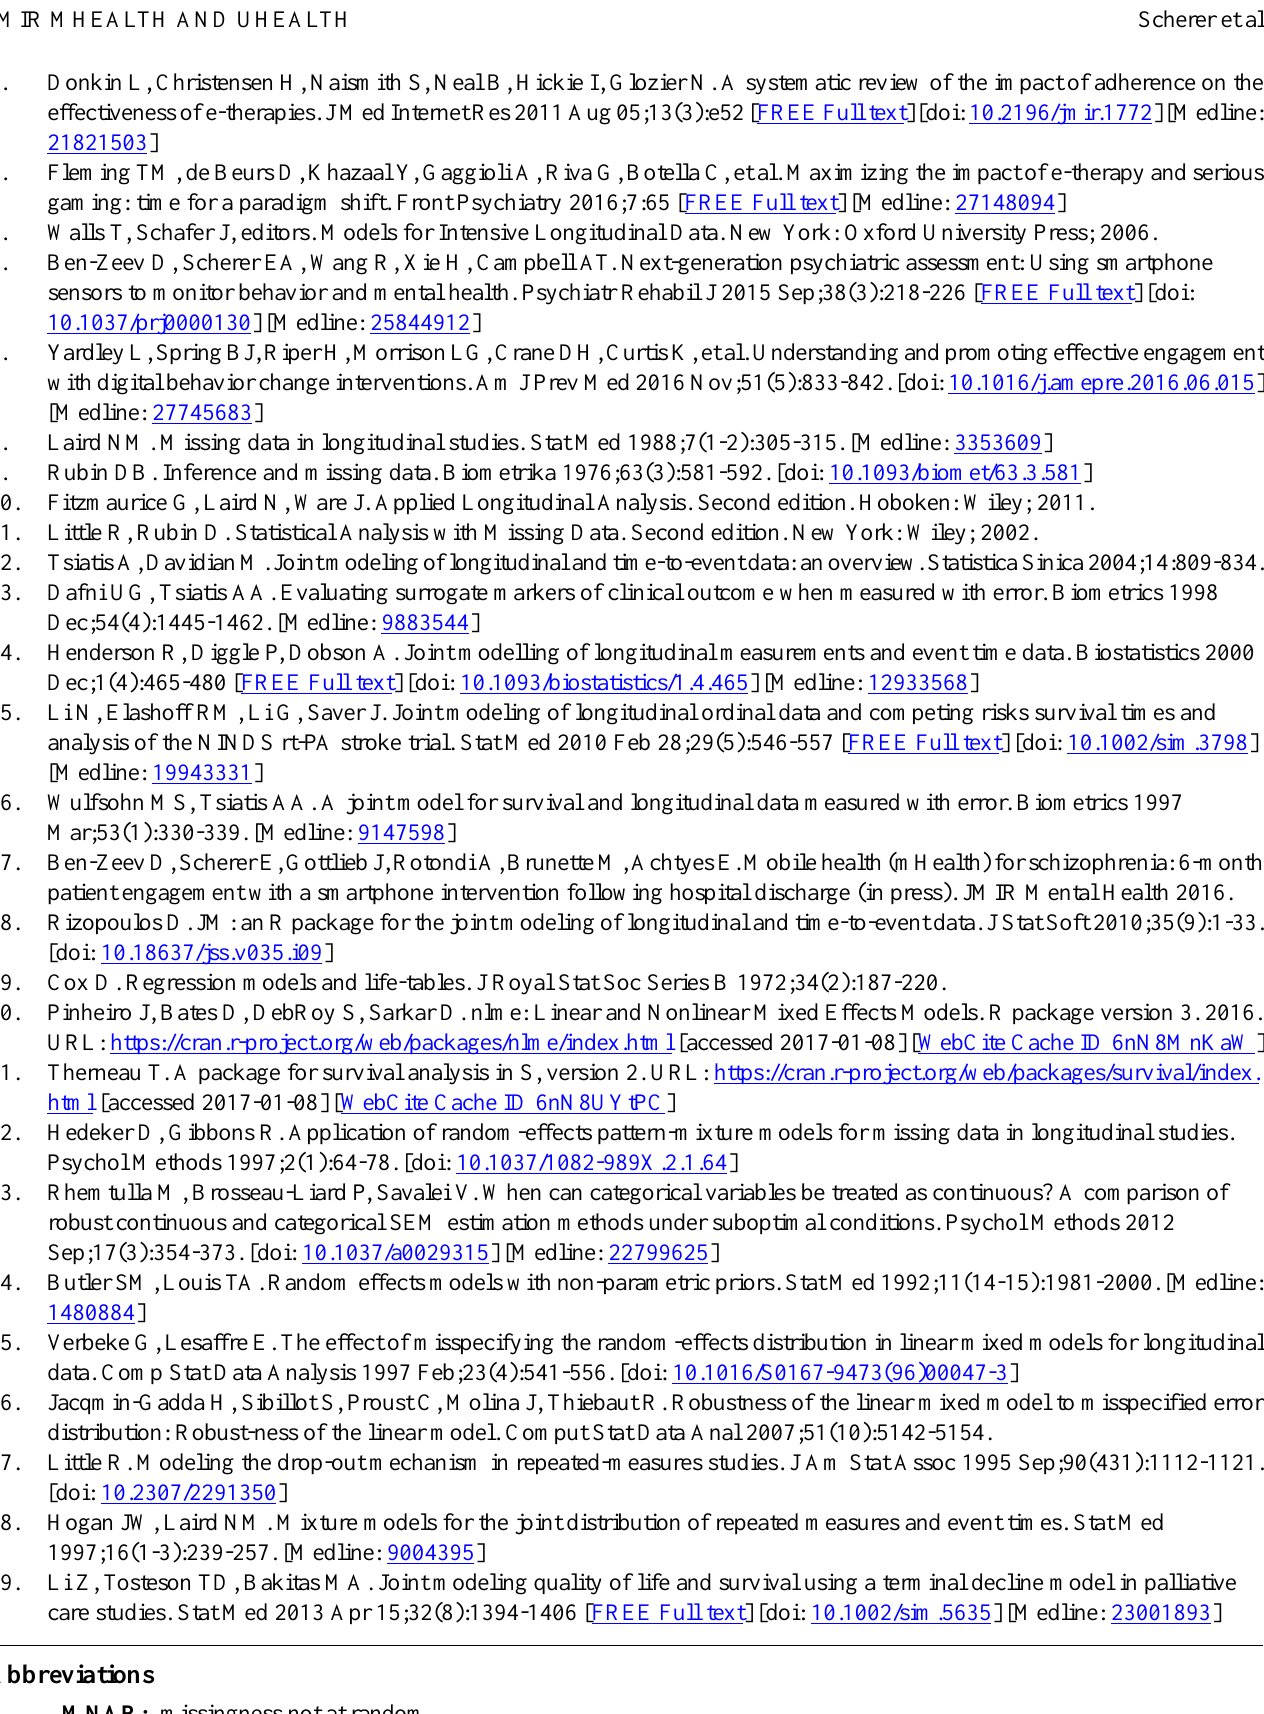
Abbreviations MNAR: missingness not at random SMS: short message